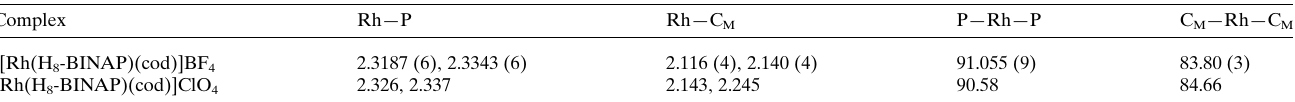
Table 1 Selected distances (A˚ ) and angles ( (cid:5) ) of the rhodium/H 8 -BINAP cod complexes (C M = centroids of the double bonds of the olefin). Complex Rh—P